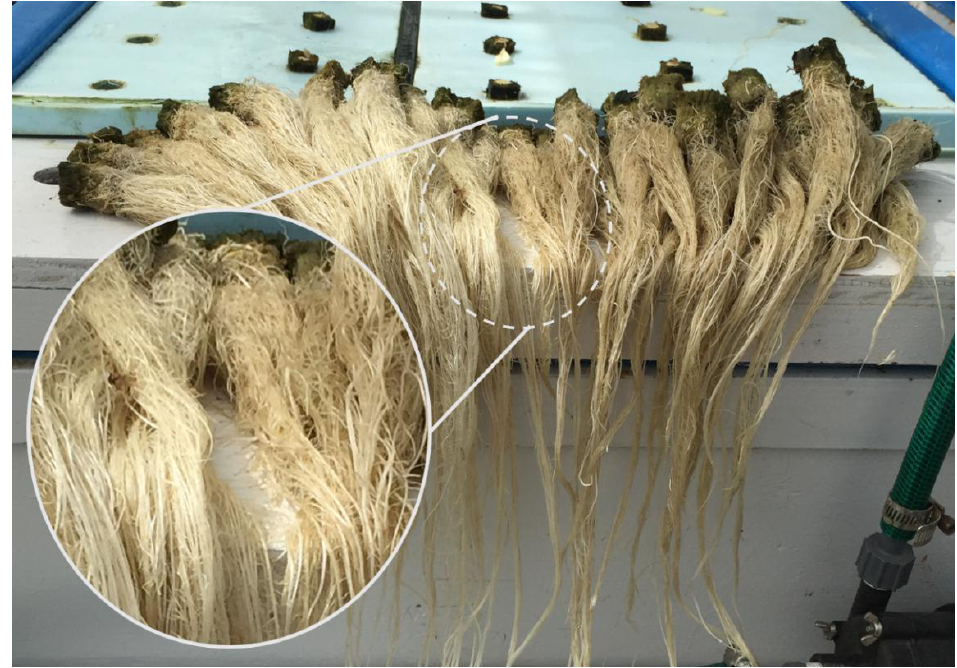
Figure 1. Individual root masses collected from hydroponic (on left) or aquaponic (on right) deep water culture systems. (raft can be seen in background with the rock wool plugs still in place after cutting off the shoot).